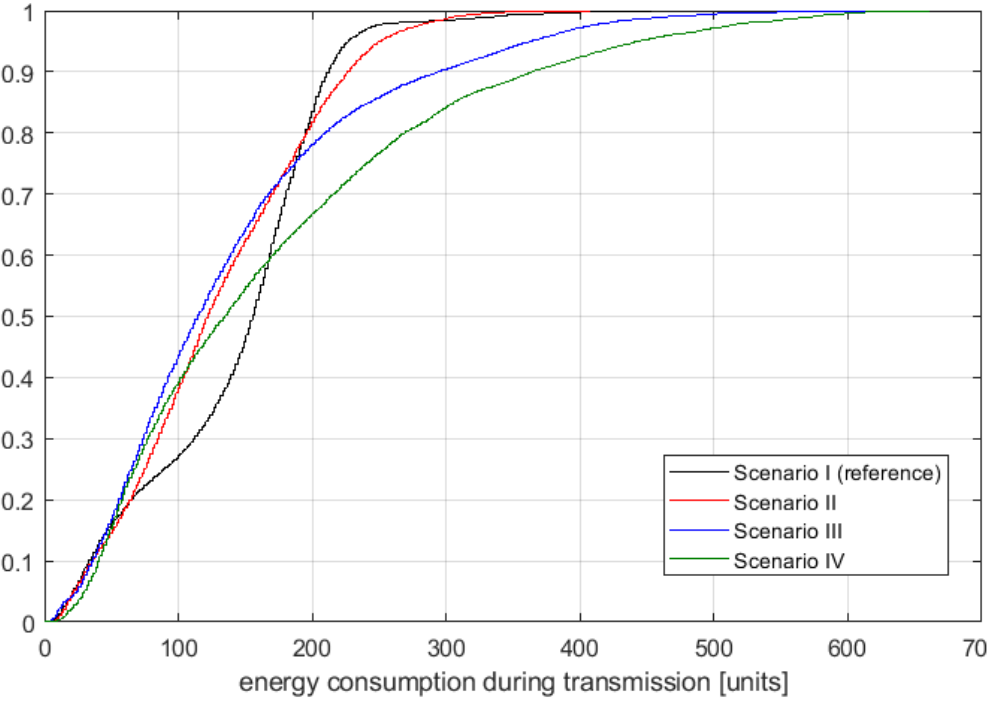
Figure 8. Distribution of energy consumption during